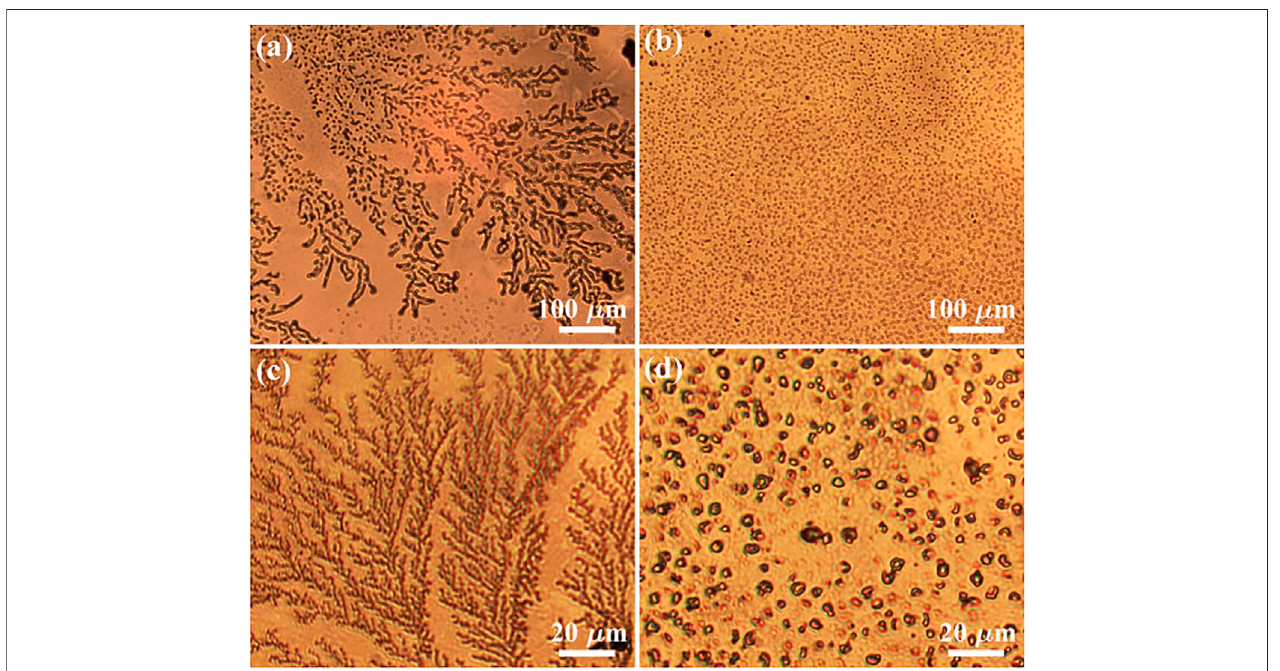
FIGURE2| Themicroscopicimagesofthesurfacemorphologyofsilver fi lmsafter plasmatreatment. (A) and (C) aretypical fractalstructuresusingpositivecorona discharge; (B) and (D) are typical random structures under negative corona discharge.